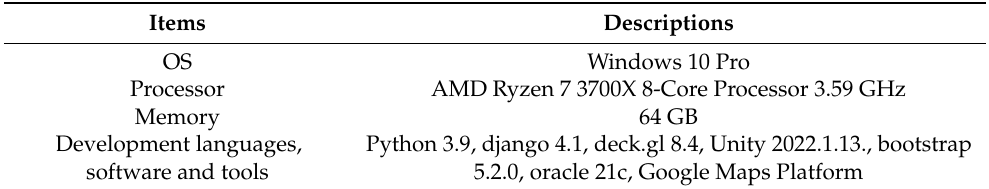
Table 9. CyCOP Implementation Environment Hardware and